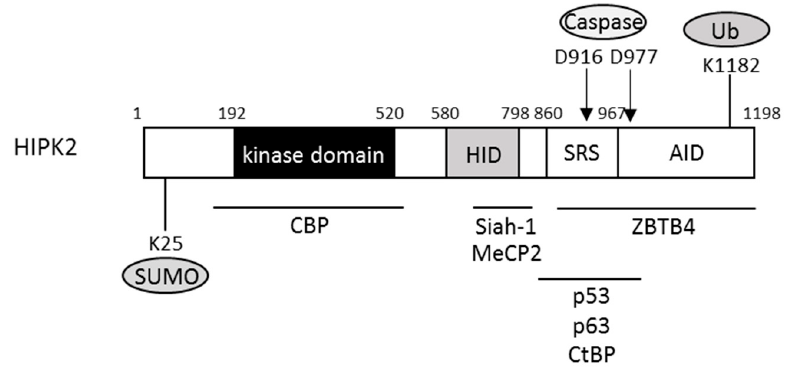
Figure 2. Schematic summary of homeodomain-interacting protein kinase 2 (HIPK2) structure. The N-terminal domain contains the sumoylation sites (K25). D916 and D977 are caspase-6 cleavage sites. K1182 is the ubiquitylation site. Some HIPK2-interacting proteins are shown. SUMO, sumoylation; Ub, ubiquitylation; HID, homeobox-interacting domain; SRS, speckle-retention signal; AID, auto-inhibitory domain; MeCP, methyl-CpG-binding protein 2; CtBP, C-terminal binding protein; CBP, cAMP-response element-binding protein (CREB)-binding protein; ZBTB4, zinc-finger and BTB domain containing 4. Table 1. Phosphorylation targets of Homeodomain-Interacting Protein Kinase 2 (HIPK2) and functional roles.